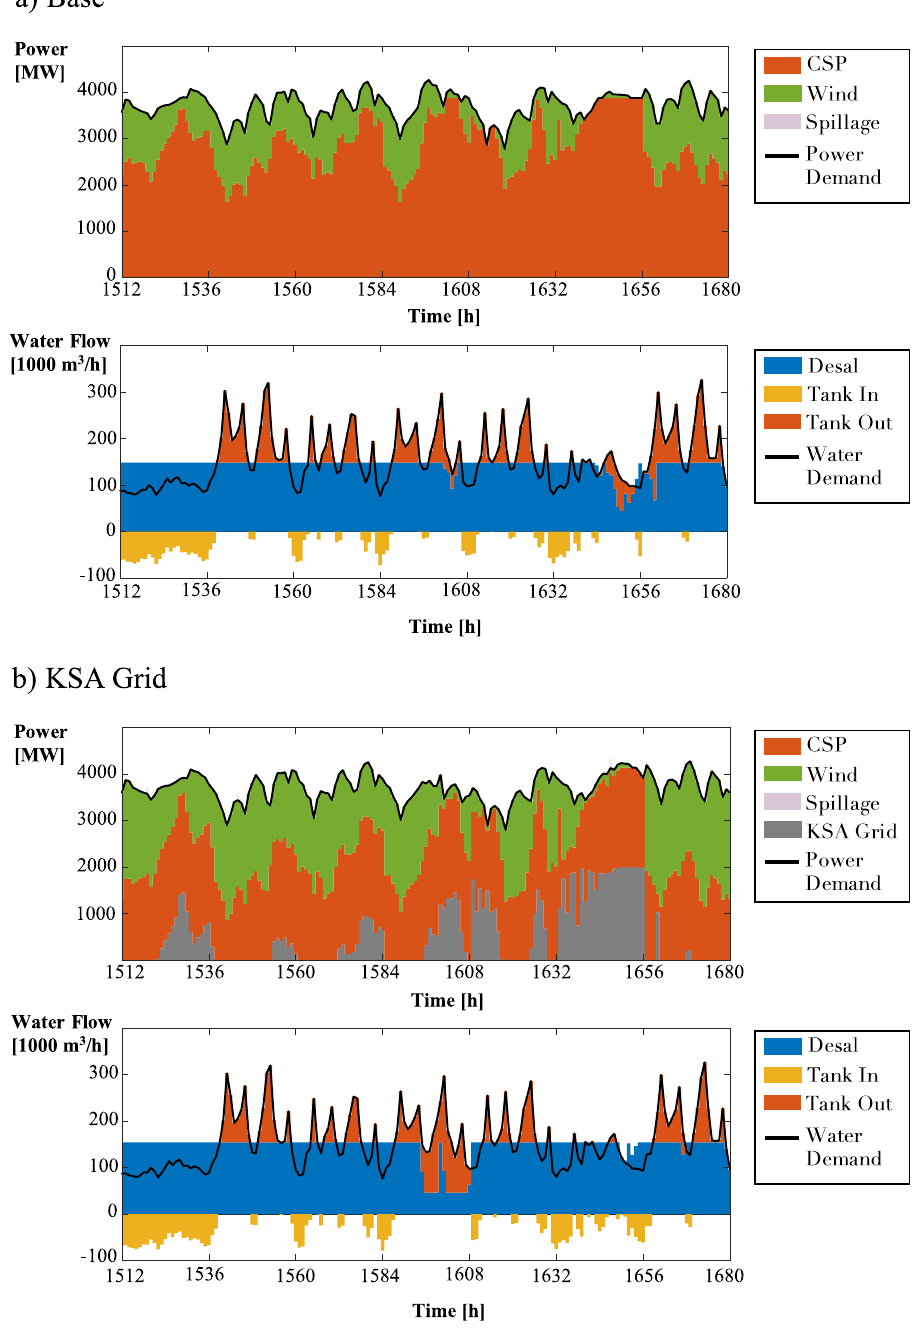
Fig. 3 Power and water system operations in year 10 for the a) Base and b) the Kingdom of Saudi Arabia (KSA) Grid cases. Desalination plants are powered entirely by concentrated solar power (CSP) at their given node; therefore, when CSP farms operate at maximum capacity, water production decreases to meet the baseline power